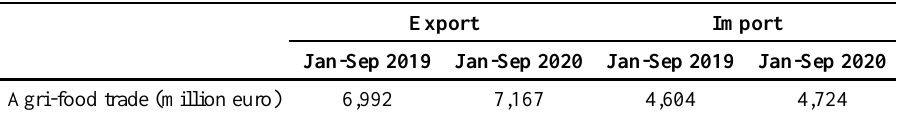
Table 4. The impacts of the pandemic on the agri-food trade